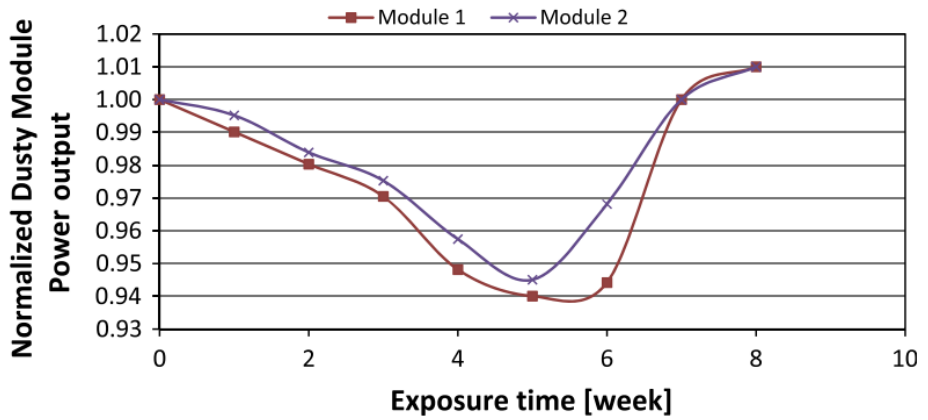
Figure 7. Normalized weekly maximum power output of dusty modules. Reprinted from Solar Energy, 107, Said, Syed A.M. et al., Fundamental studies on dust fouling effects on PV module performance, 331., Copyright (2014), with permission from Elsevier[59].